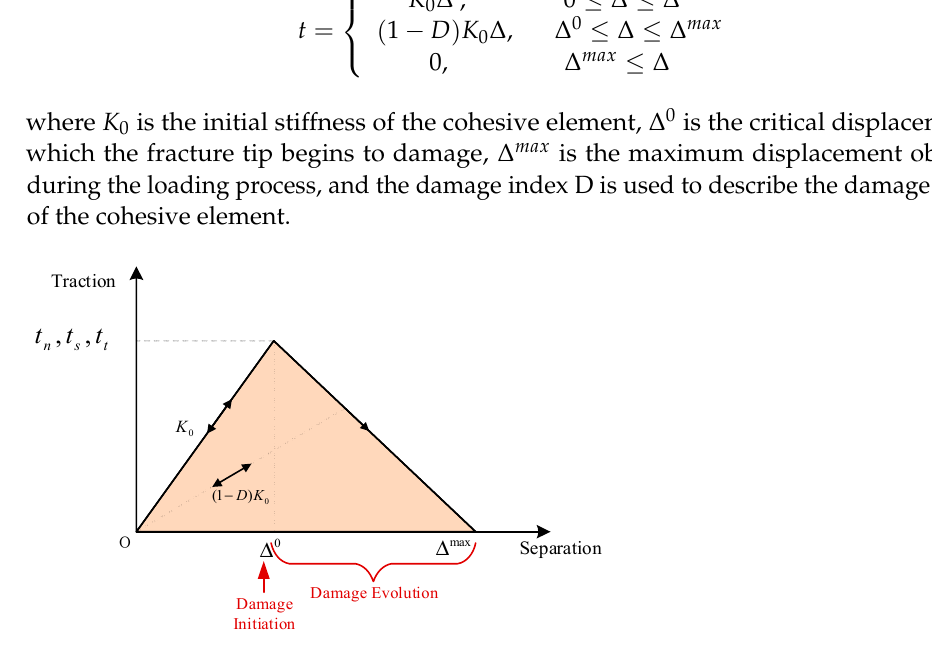
Figure 2. Cohesive traction–separation law with linear damage evolution.